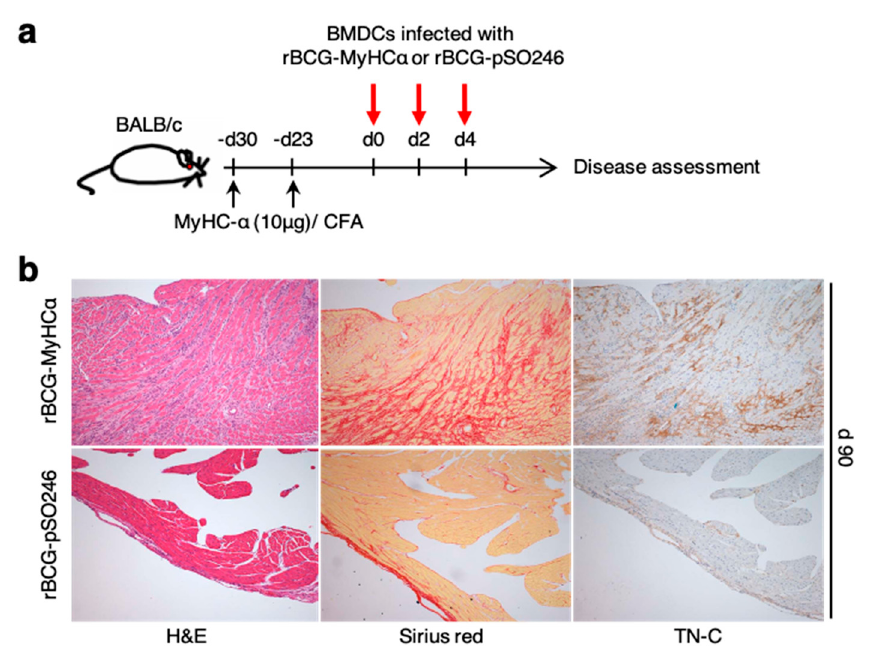
Figure 10. rBCG-MyHC α -infected DCs induced chronic myocarditis. ( a ) After priming with 10 µ g of MyHC α peptides on days-30 and -23, BMDCs infected with rBCG-MyHC α or rBCG-pSO246 were injected into mice on days 0, 2, and 4. ( b ) Representative histology (H&E and Sirius red staining and TN-C immunostaining) of the heart sections on 90 days after DC injection.